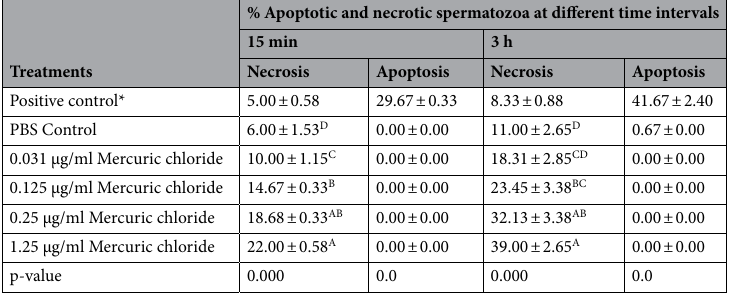
Table 5. Effect of in-vitro exposure of buck-spermatozoa to different concentrations of mercuric chloride (0.031–1.25 µg/ml) on early apoptosis and necrosis at different time intervals. Data presented are mean ± SE of the semen samples of six bucks. Different capital superscripts in the columns indicate significant (p < 0.05) differences between the different treatment groups. *Camptothecin (10 µM) treated buck semen sample.